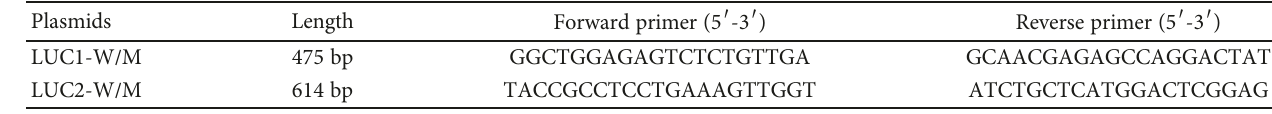
Table 1: Primers for the constructed LUC1-W/M and LUC2-W/M plasmids.